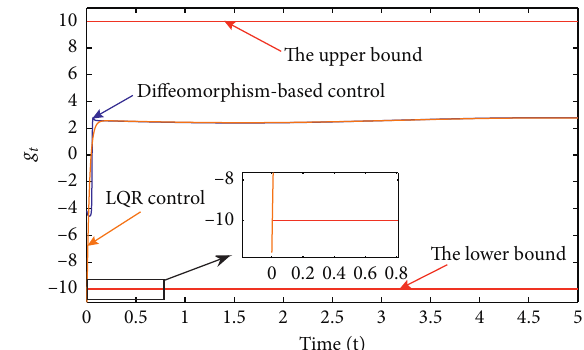
Figure 7: Time history of actual control g